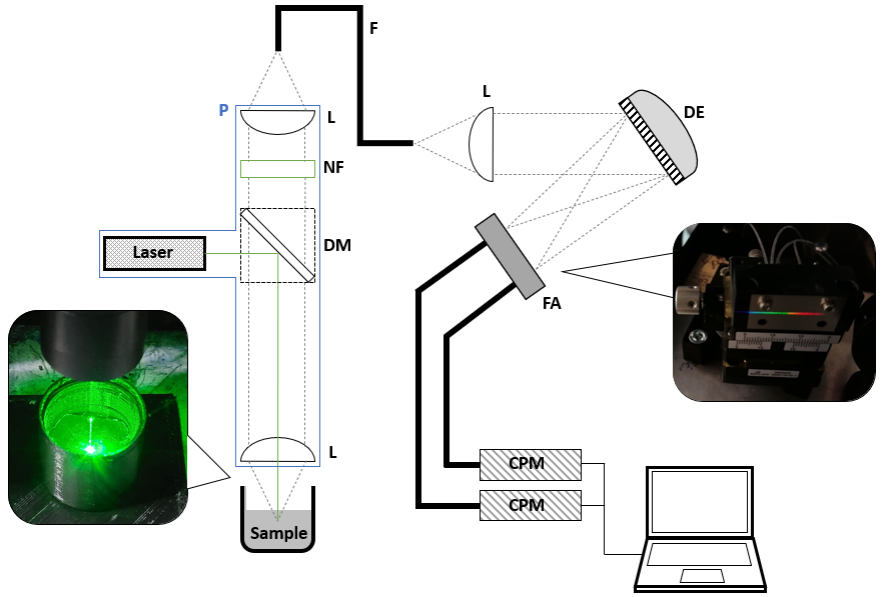
Figure 2. Schematic diagram of the Raman sensor prototype. P = probe, DM = dichroic mirror, NF = 532 nm notch filter, L = lens, F = fiber, DE = dispersive element, FA = fiber array, CPM = custom photon multiplier.